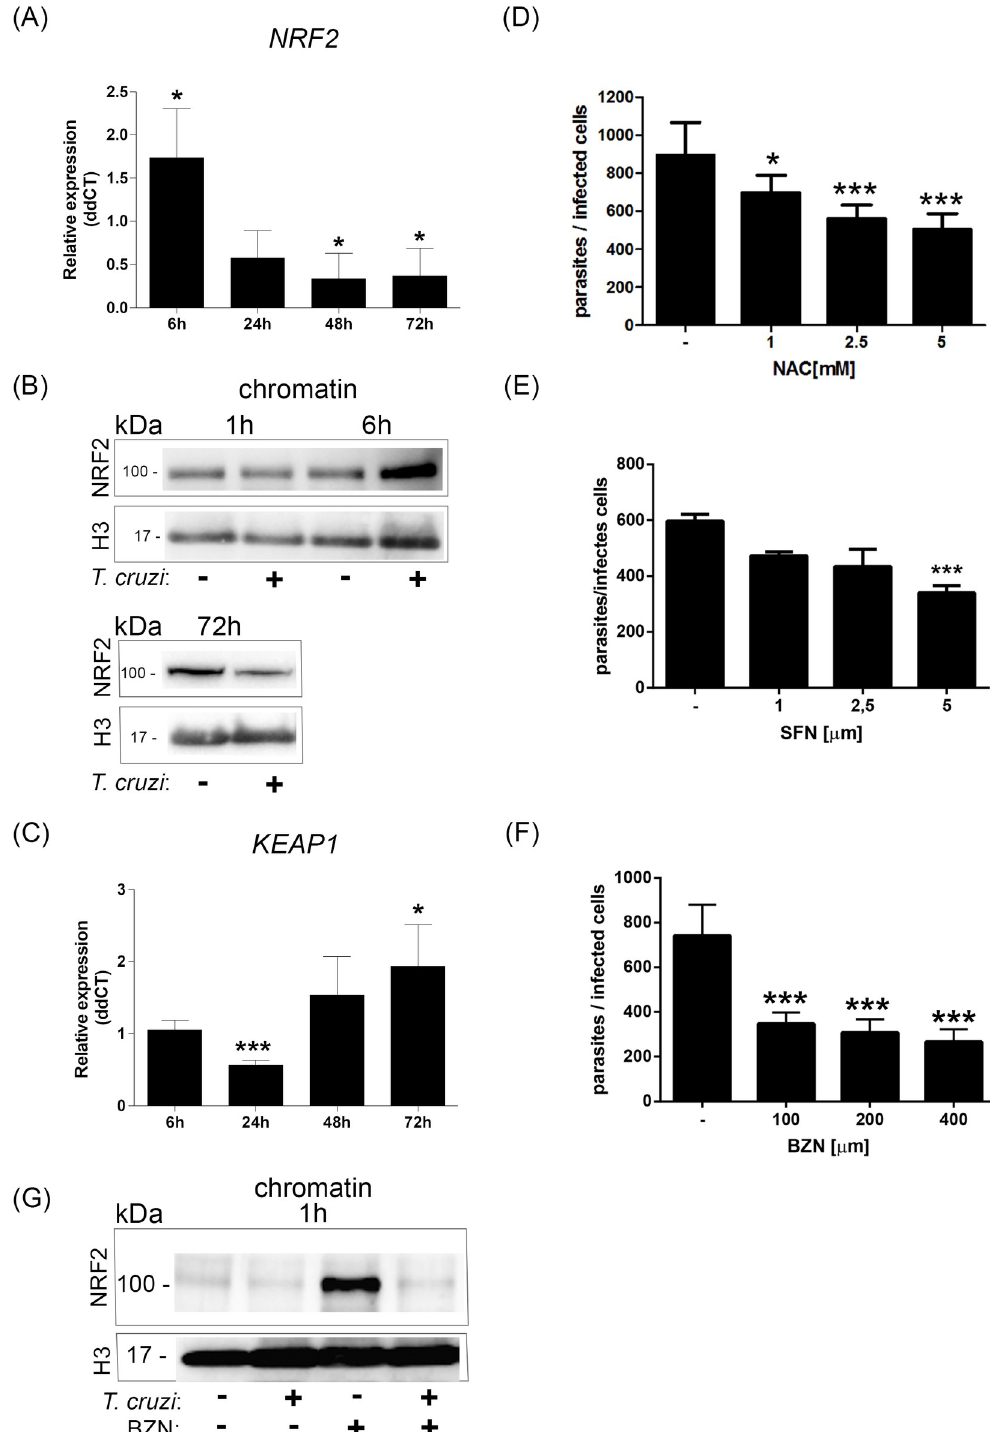
Fig 4. Early NRF2 activation is not sustained during infection. (A) Relative expression (ddCT) from gene NRF2 from infected cells compared to control 6 h, 24 h, 48 h, and 72 h post-infection (p.i.). ACTB gene was used as the endogenous control. The bar graph represents the mean and standard deviation of mRNA relative expression of infected cells compared to the control; � p < 0.05. (B) Isolated chromatin from infected (+) or control cells (-) 1 h, 6 h, or 72 h p.i. were immunoblotted with anti-NRF2. The loading control was assessed by anti-histone 3 (H3). (C) Gene KEAP1 ddCT from